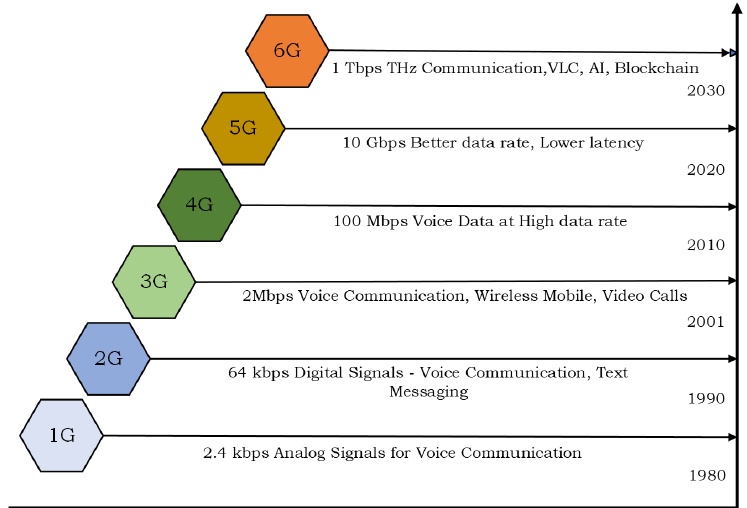
Figure 1. Cellular technology